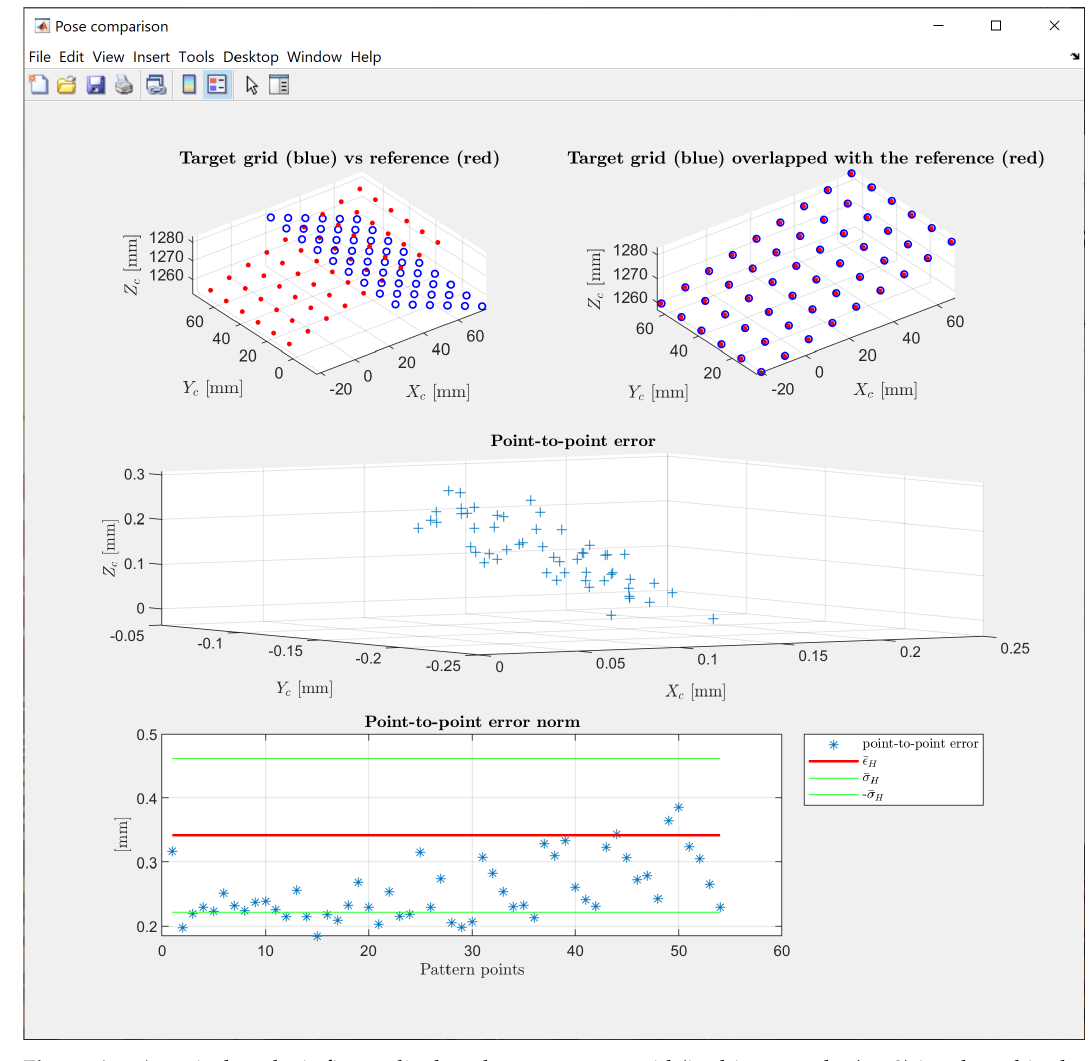
Figure A4. A typical analysis figure displayed once a target grid (in this example, i = 2) is selected in the Error analysis tab of Figure A3b, showing the following: at the top, the reference grid ( X target grid (in blue) before ( X 2 ) and after (the reprojected grid X 1 ) the overlapping, respectively; at the center, their point-to-point errors ( (cid:101) j , i , H , j = 1, . . . ,54, i = 2, and for a certain H ); at the bottom, the norm of these (cid:101) j , i , H errors ( , blue asterisks), the T-averaged point-to-point error ( (cid:101) H , red line) and its standard deviation ( | | green lines). A ( ˜ ω 1 , ˜ ω 2 , ˜ q ) H previously obtained from the Turntable Calibration tab was